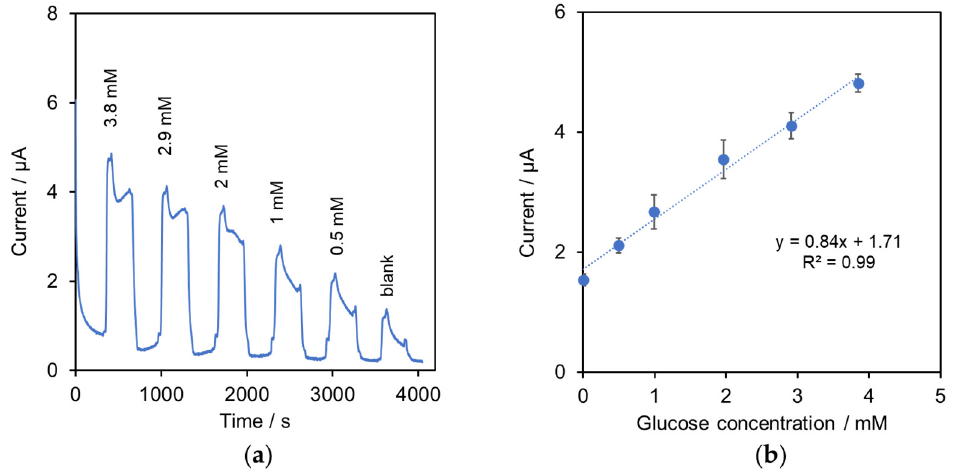
Figure 3. The system with the GOD–SWCNTs–AuNPs-modified SPE: ( a ) amperometric responses obtained from the system with various concentrations of glucose in DMEM from 0.5 to 3.8 mM with flow rate 0.4 mL min − 1 ; ( b ) calibration plot of peak current and glucose concentration, n = 3.